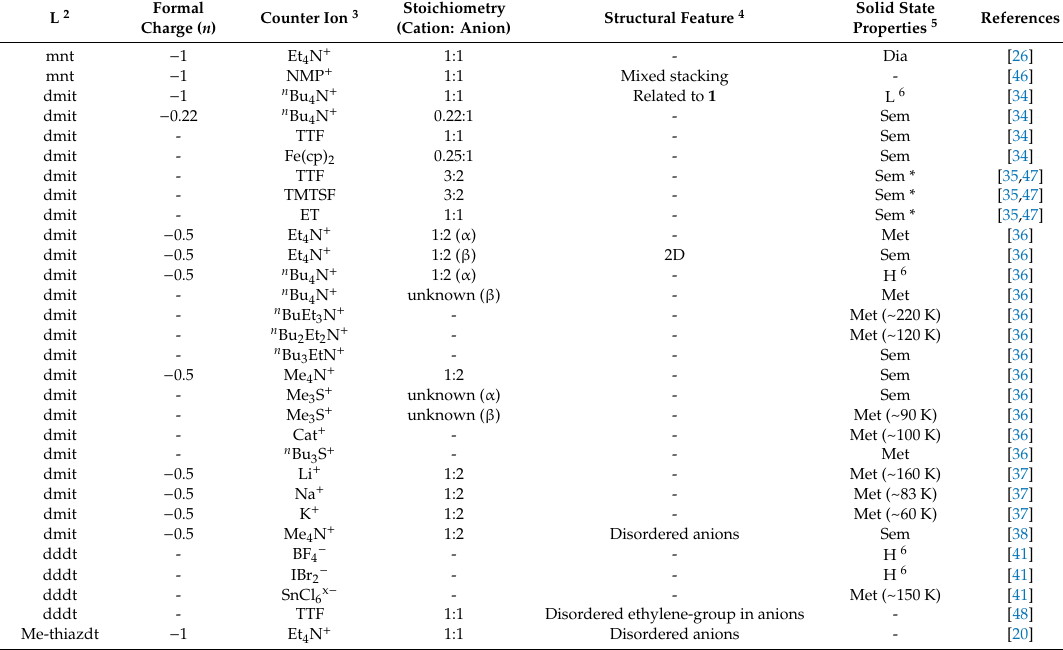
Table 1. Crystalline Gold(III)-dithiolene complexes containing ionic [Au(III)L 2 ] n ( − 1 ≤ n ≤ 1, n (cid:44) 0) 1 . L